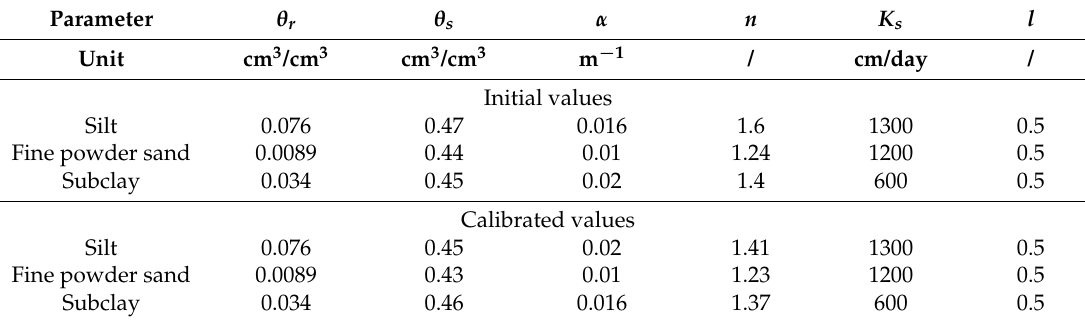
Table 1. Soil-moisture parameters.